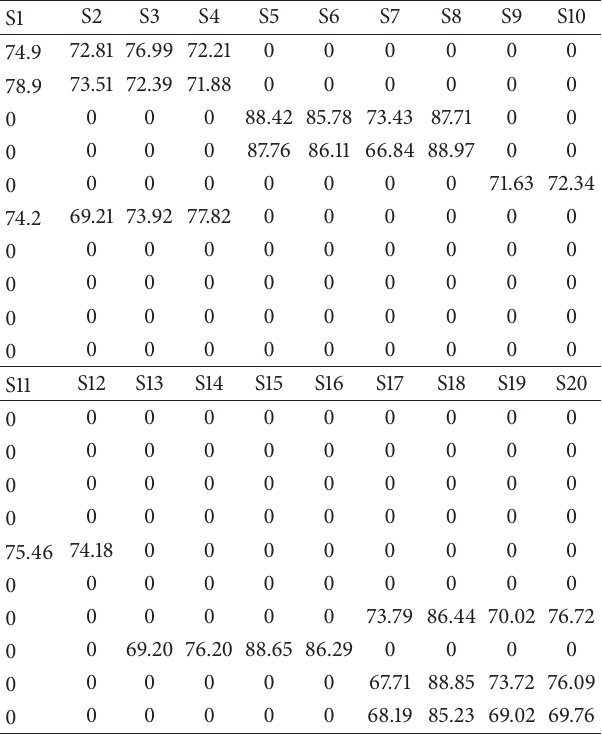
Table 5 explains the comparison of different modality combinations and their recognition accuracy. From the classified result, it was concluded that the performance of